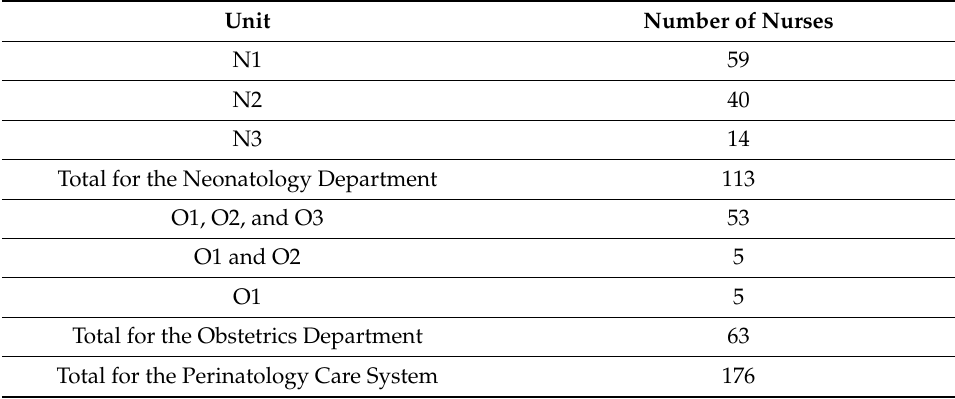
The number of nurses registered in each unit is provided in Table 5. Table 5. Number of available nurses in each